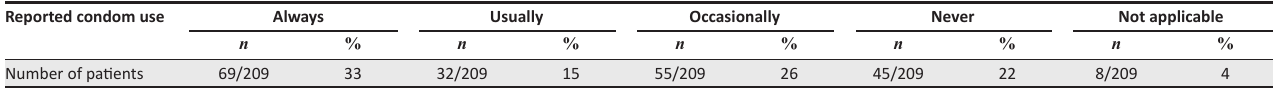
TABLE 8: Reported condom use. Reported condom